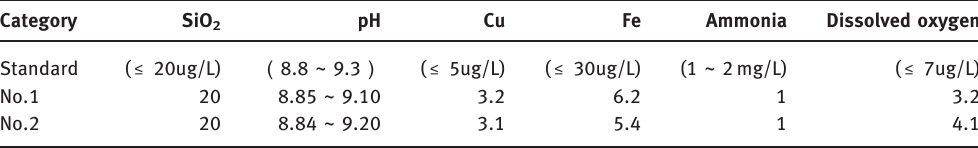
Table 2: Water quality analysis of the boiler feedwater.